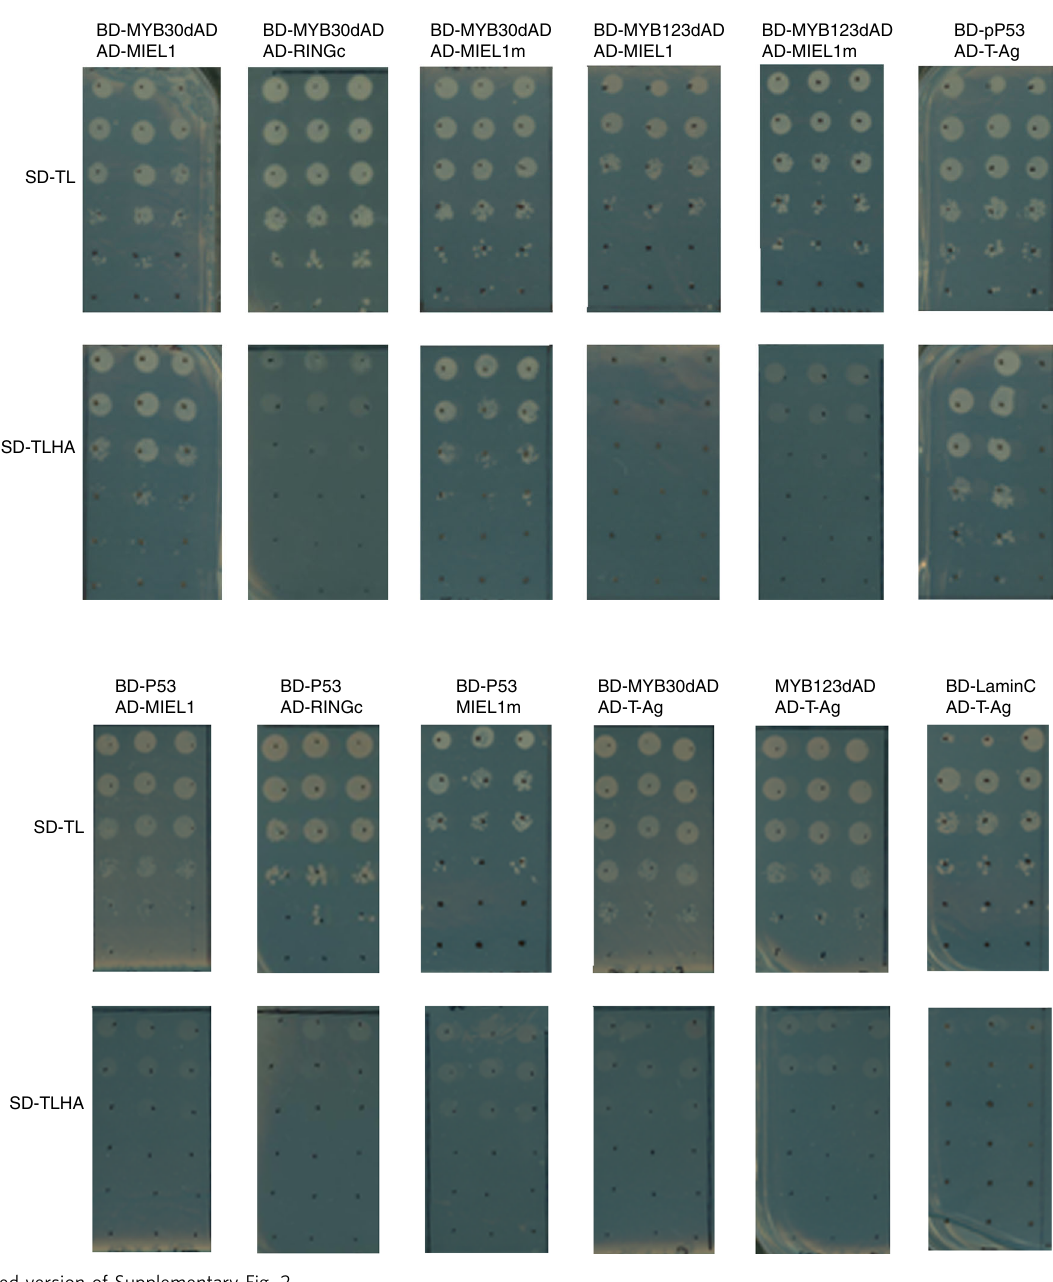
Fig. 2 Updated version of Supplementary Fig.